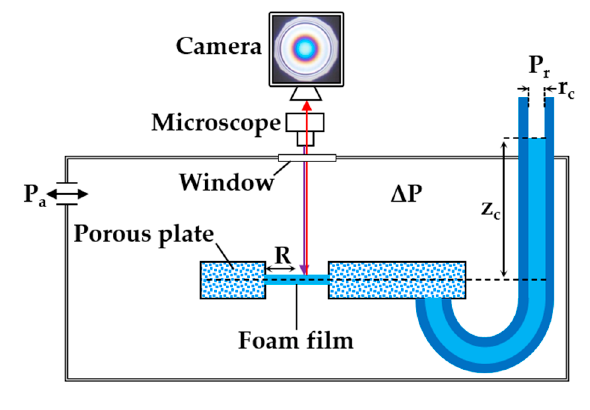
Figure 2. Schematic drawing of the porous plate cell set up for investigations of foam